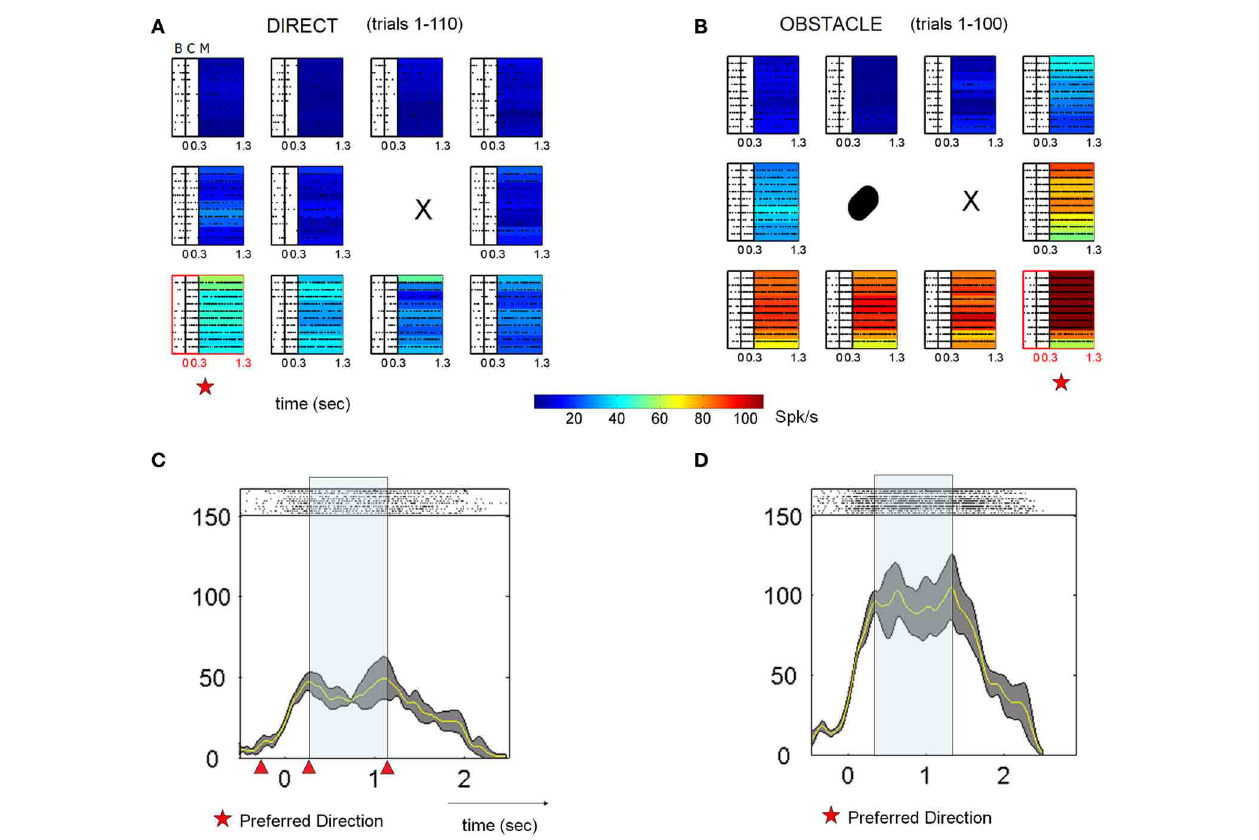
transiently differed between conditions. Note that the neuron began to reduce its firing rate over the last few trials for most locations. (C,D) Peristimulus time histograms (PSTHs) of activity associated with the preferred location, along with spike rasters. Earlier trials are the bottom rows and triangles mark the ending of the baseline, cue and memory in that order from left to